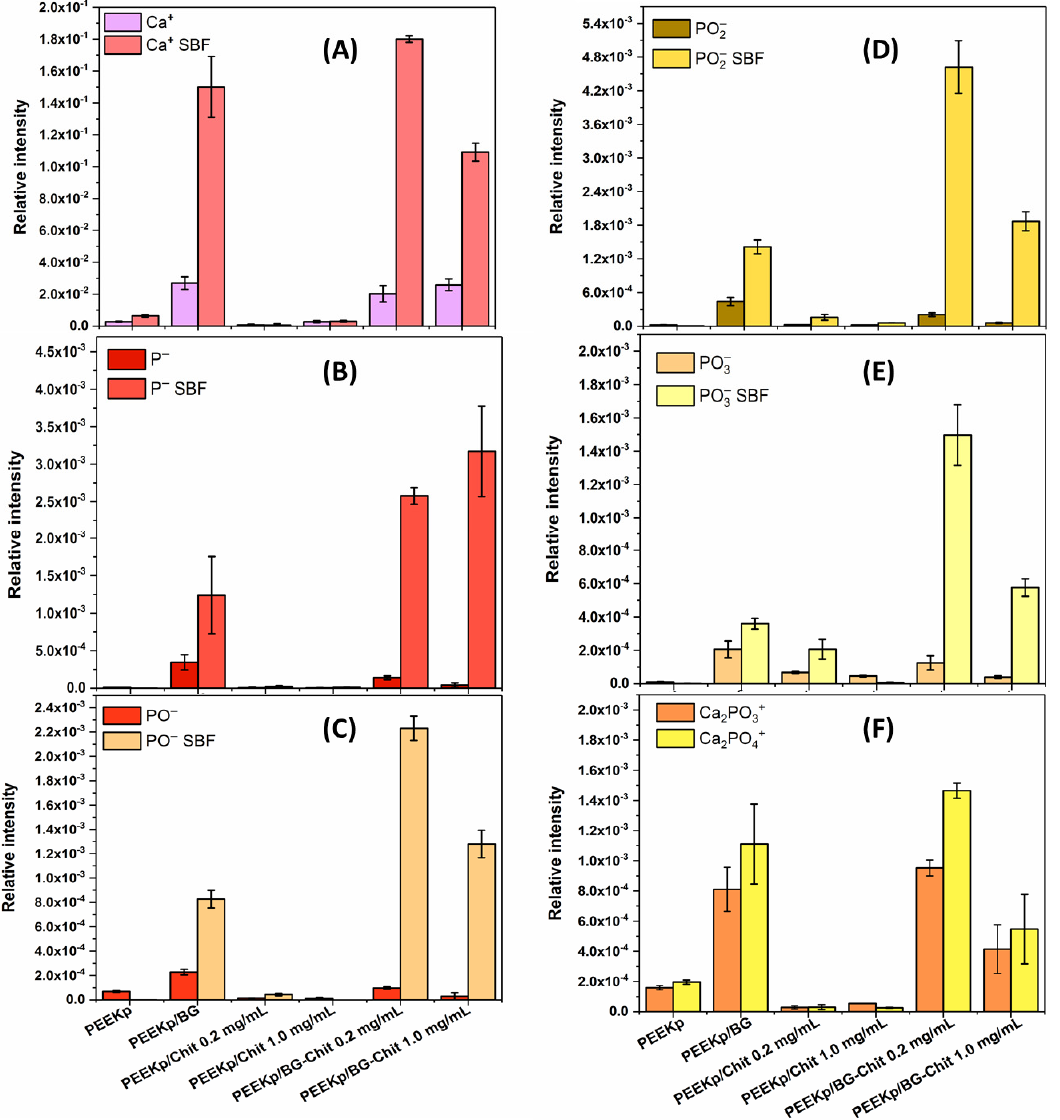
Figure 9. ( A ) Relative intensities of calcium (𝐶𝑎 (cid:2878) ), ( B) phosphorus ( 𝑃 (cid:2879) ), phosphate fragments ( C ) 𝑃𝑂 (cid:2879) , ( D ) 𝑃𝑂 (cid:2870)(cid:2879) , and ( E ) 𝑃𝑂 (cid:2871)(cid:2879) ions determined on the modified PEEK surfaces before and after the incubation in SBF. Figure ( F ) calcium phosphate 𝐶𝑎 (cid:2870) 𝑃𝑂 (cid:2871)(cid:2878) and 𝐶𝑎 (cid:2870) 𝑃𝑂 (cid:2872)(cid:2878) ions appeared after incubation process.